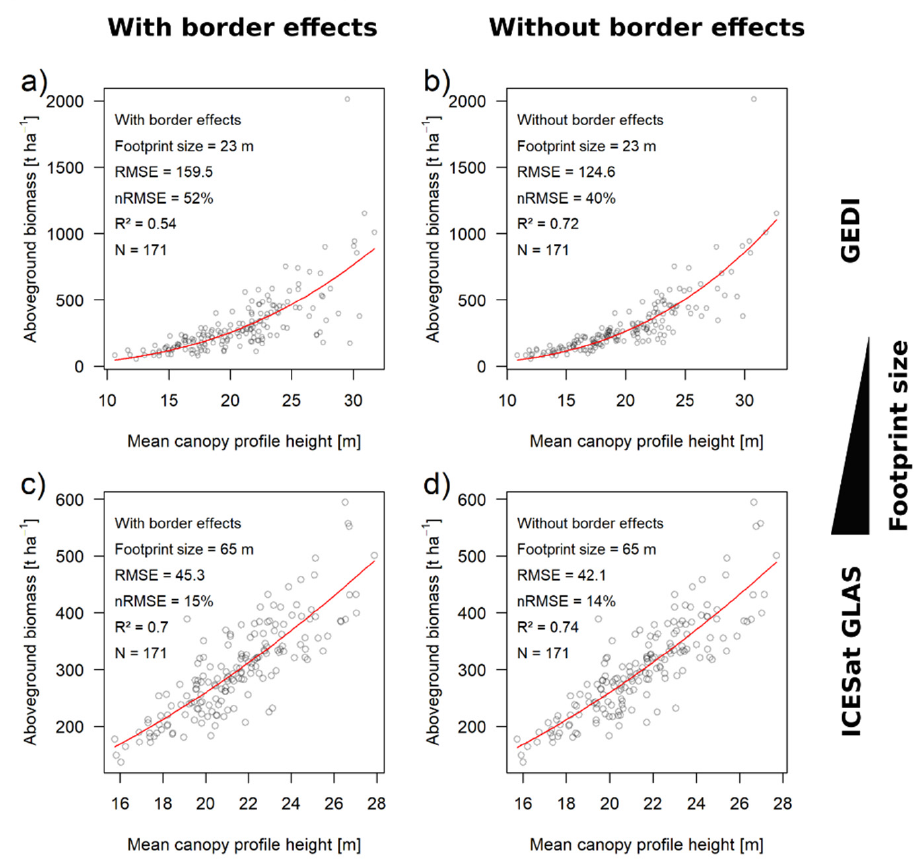
Figure 5. Height–biomass relationship for large lidar footprints. The scatterplots show the above- ground biomass (AGB) plotted over the mean canopy profile height (MCH derived from waveform simulations) at the footprint sizes of the GEDI ( a , b ) and ICESat GLAS ( c , d ) sensor systems. The red lines represent the best-fitting regression models. The left-hand side shows the normal conditions with border effects ( a , c ). The right-hand side shows the relationships derived from the data with the border effects switched off, using periodic boundaries ( b , d ).